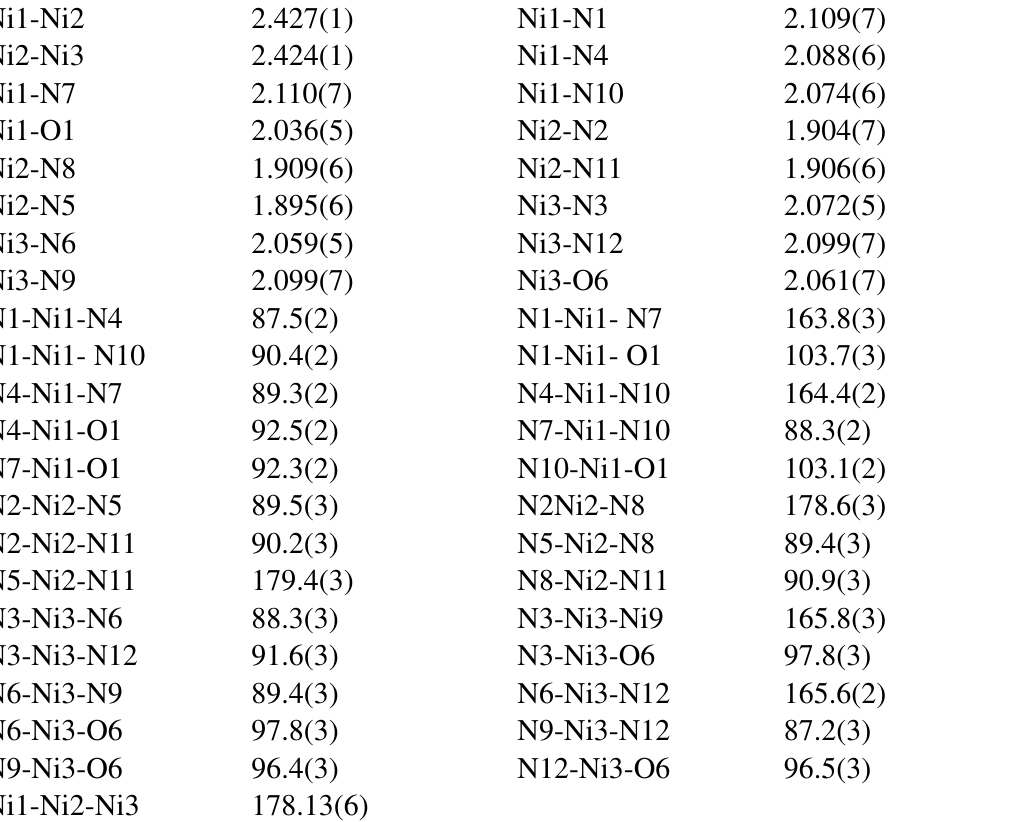
Table 1. Selected bond lengths (Å) and angles (°) for complex 1